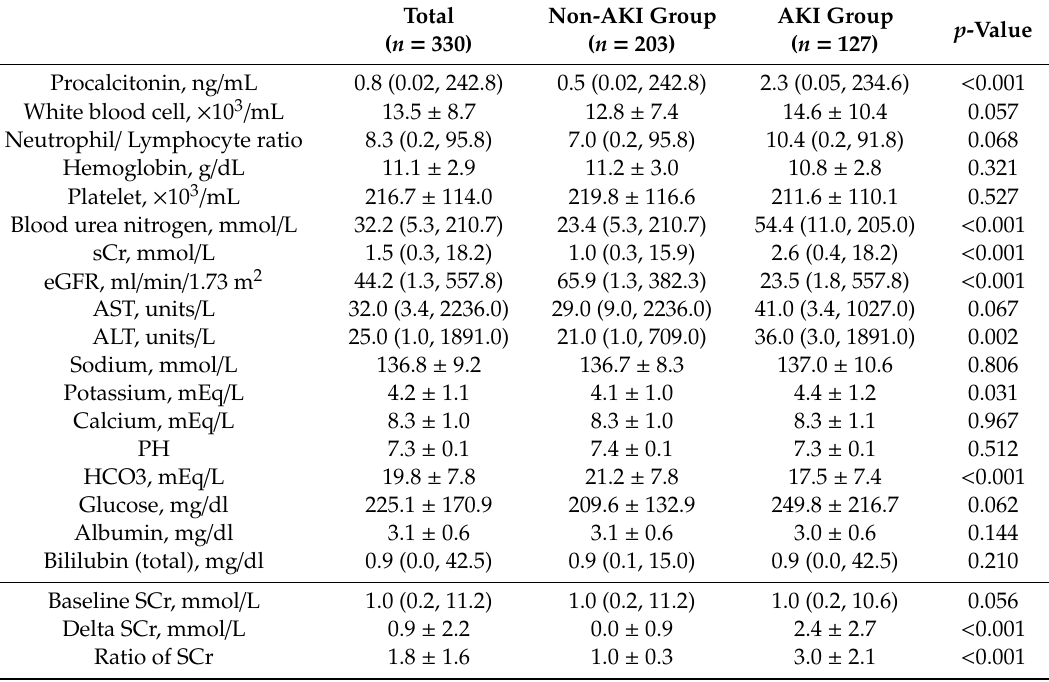
Table 2. Comparisons of laboratory data of the two